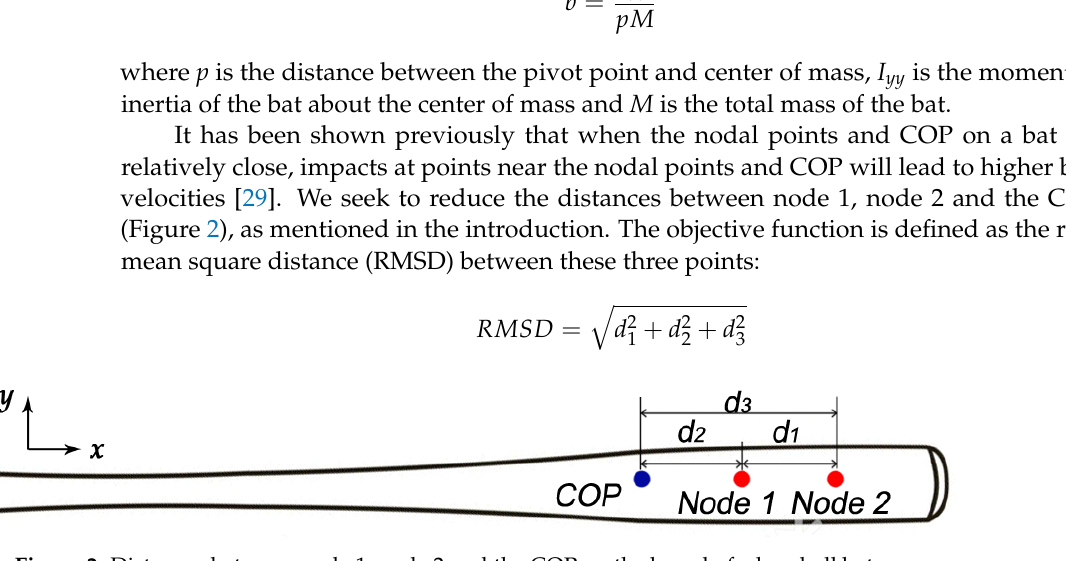
Figure 2. Distances between node 1, node 2 and the COP on the barrel of a baseball bat.